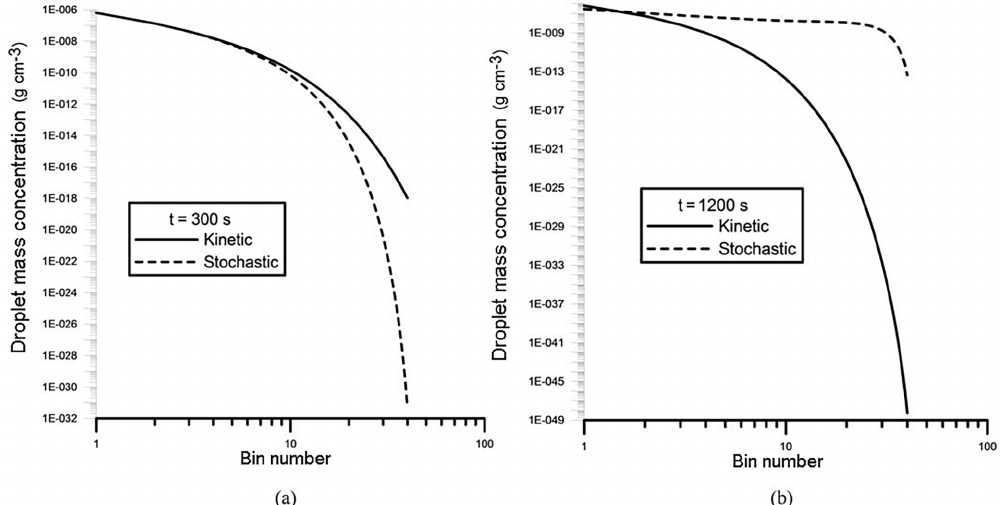
Figure 5. Size distributions obtained from the stochastic master equation (dashed lines) and the KCE (solid lines) at (a) t = 300s and (b) t = 1200s. Simulations were performed with the collection kernel K(i,j) = Cx i x j (with C = 5 . 49 × 10 10 cm 3 g − 2 s − 1 ) . The initial number of droplets was set equal to N = 40 droplets of 17µm in radius in a volume of 1cm 3 . For the large end, the stochastic approach shows larger values of the drop mass concentration after the sol–gel transition.